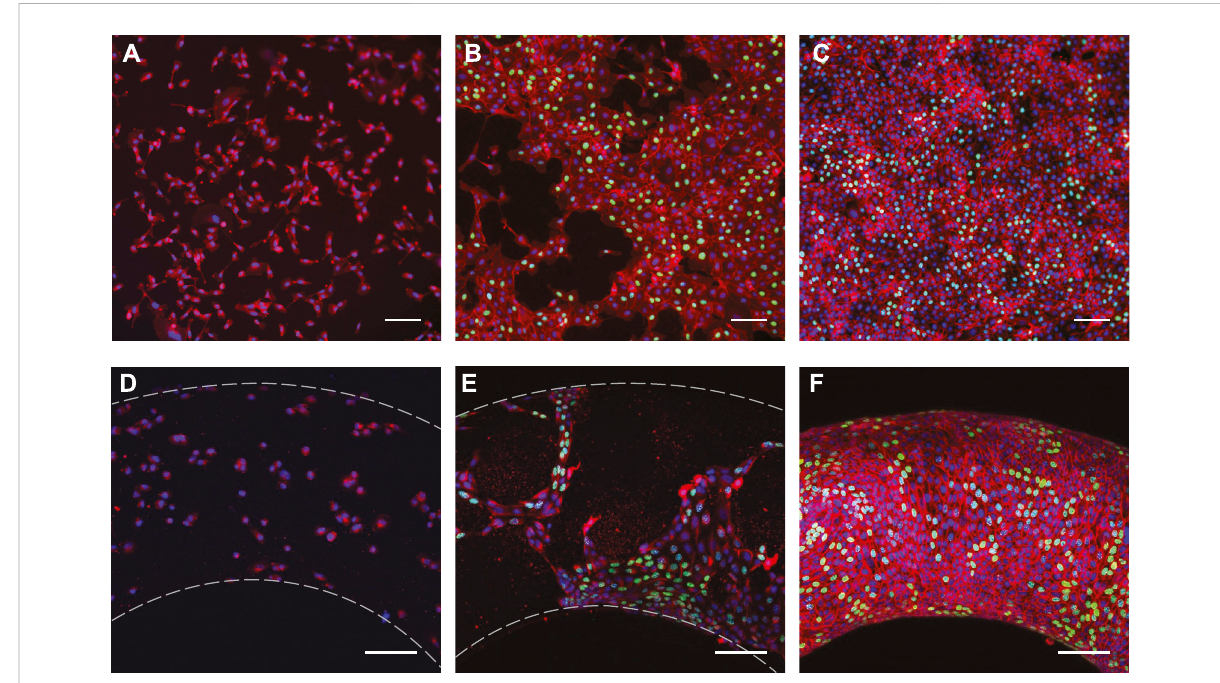
FIGURE 3 FluorescencemicroscopyimagesofMDCKIIcellsculturedonplanar(toprow)andtoroidal(bottomrow)PAhydrogelsafter (A,D) 2 h (B,E) 26h, and (C,F) 52 h. Images in the bottom row are maximum intensity projections of confocal stacks. Samples were stained for nuclei (DNA) and E-cadherin, which are false-colored in blue and red,respectively. Newly synthesizedDNA was labeled by EdU for the 26 and 52 hsamples, shown in green. Scale bars: 100 μ